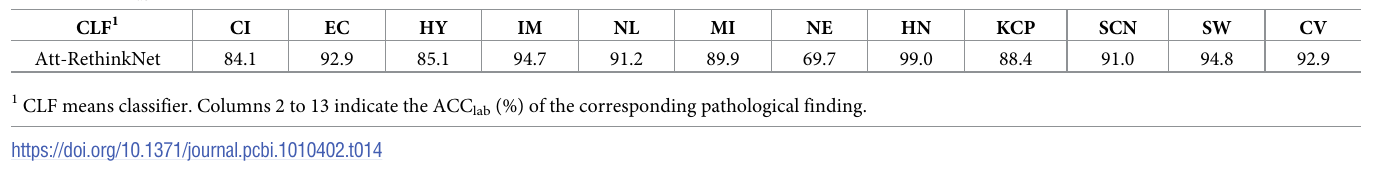
Table 14. ACC lab of Att-RethinkNet for liver in vitro